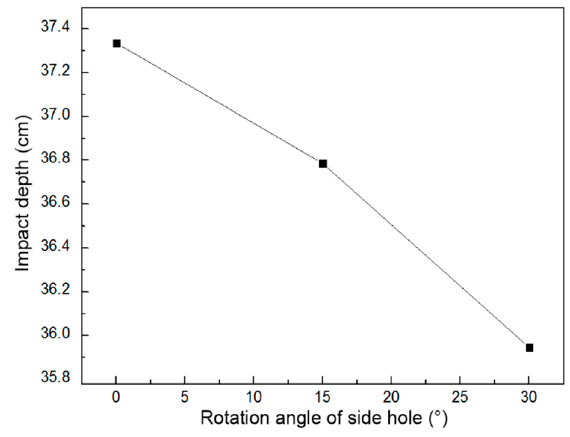
Figure 15. The e ff ect of rotation angle of side holes for the impact depth of liquid Figure 15. The effect of rotation angle of side holes for the impact depth of liquid steel.